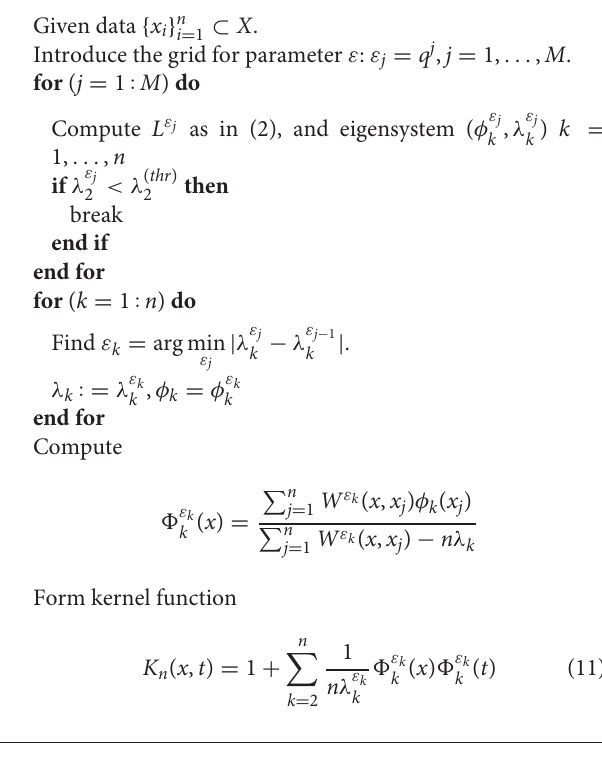
Algorithm 2 uses the constructed kernel (11) in kernel ridge regression from labeled data. The regression is performed